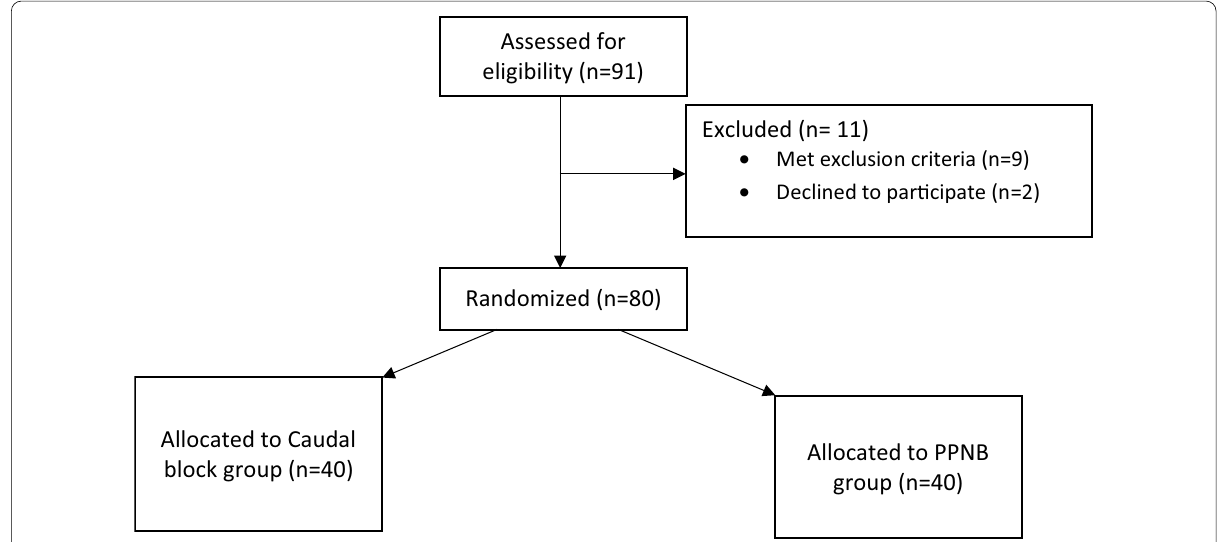
Fig. 1 Flow diagram showing how participants were recruited and allocated to the two intervention groups